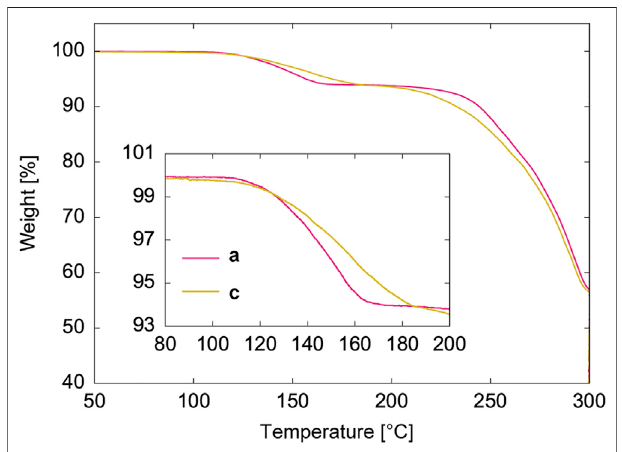
FIGURE3| TGApro fi les ofas-synthesized pre-ELM-11 particles(a) and air-exposed particles (c). The labels of a and c correspond to those in Figure 1A . Inset is a magni fi ed graph in a temperature range from 80 to 200 ° C.